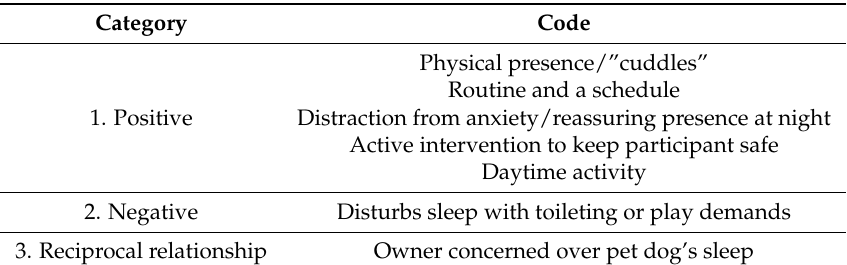
Table 2. Categories of codes from statements specific to dogs and